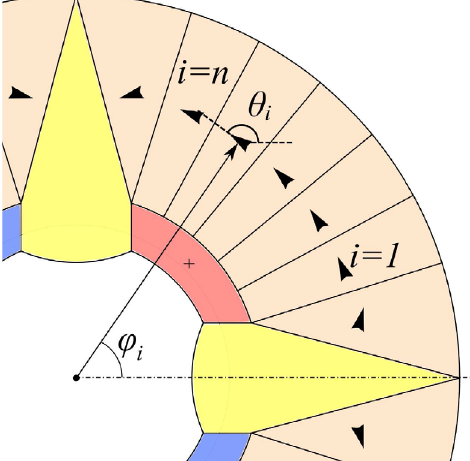
FIG. 8. Angles of magnetization for a single quadrant of the hybrid magnet design.